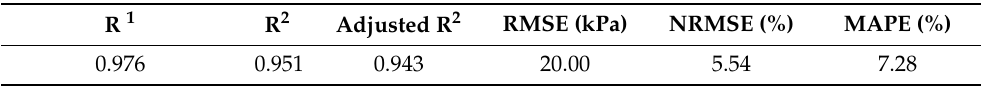
Table 7. Summary of the regression analysis outputs with respect to Equation (11).